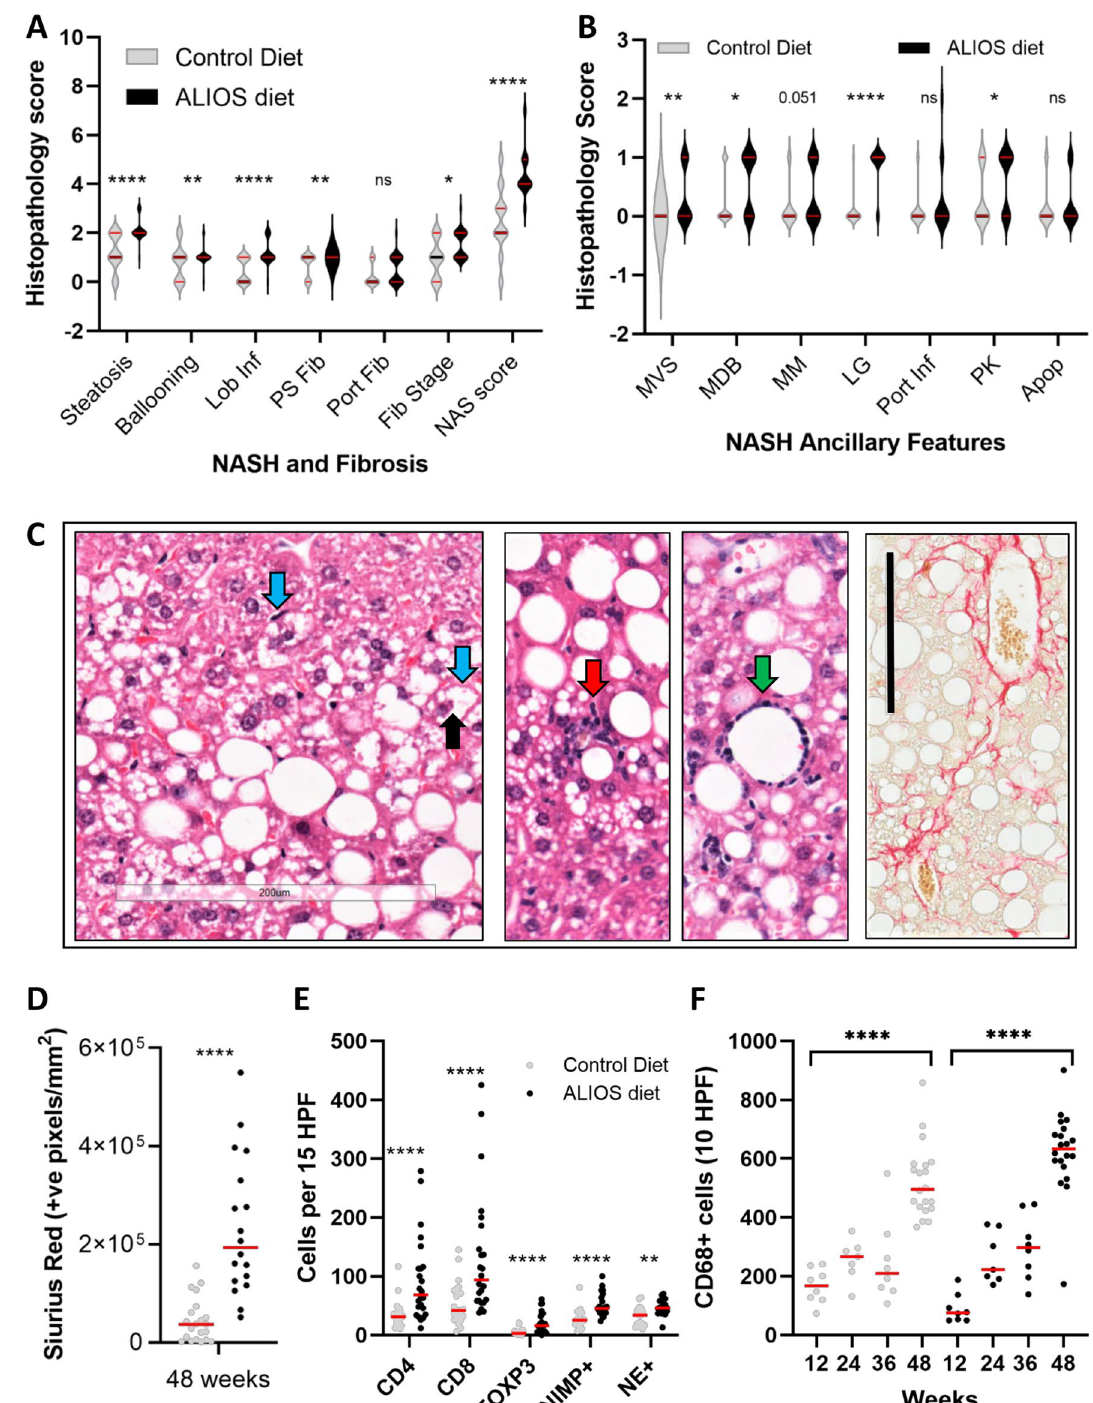
Figure 3. DINAH model histopathology features of NASH. In the livers of 48 weeks control diet C3H/He mice, mild to moderate NAFLD was common, although expert histological assessment confirmed ALIOS induced features of more severe disease, with significantly increased steatosis, lobular inflammation (Lob Inf) and fibrosis ( A ), as well as microvesiular steatosis (MVS), Mallory Denk Bodies (MDB), lipogranulomas (LG) and pigmented Kupffer cells (KP). Arrows in ( C ) depict lobular inflammation (red), ballooned hepatocytes (blue), Mallory–Denk bodies (black) and macrophages around a lipid droplet—a lipogranuloma (green). Sirius Red ( C , far right) positive pixels captured by Aperio Image analysis confirmed significant elevations in pericellular fibrosis in ALIOS fed mice at 48 weeks ( D ), with an example in ( C , far right). There were significant elevations in CD4 + , CD8 + and FOXP3 + T lymphocytes, as well as NIMP + and neutrophil elastase + neutrophils ( E ). Quantification of CD68 + macrophages confirmed a step wise increase from 12 to 48 weeks of age, more marked in ALIOS fed mice ( F ). Statistical differences were determined by Chi Square or Mann–Whitney Tests (ns = not significant, ** p < 0.01, *** p < 0.001, **** p < 0.0001. Additional Key: PS—perisinusoidal, Fib fibrosis, MM—megamitochndria, Port—portal, Apop